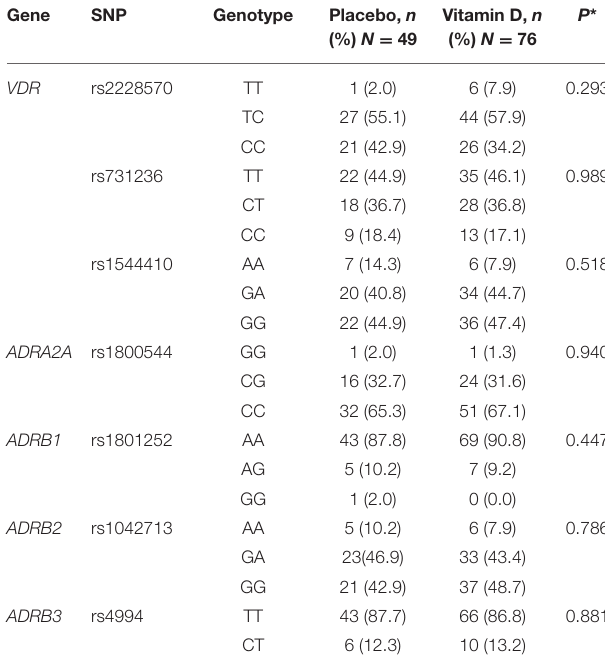
TABLE 2 | Serum 25(OH)D levels and obesity markers at baseline and after intervention. Variables